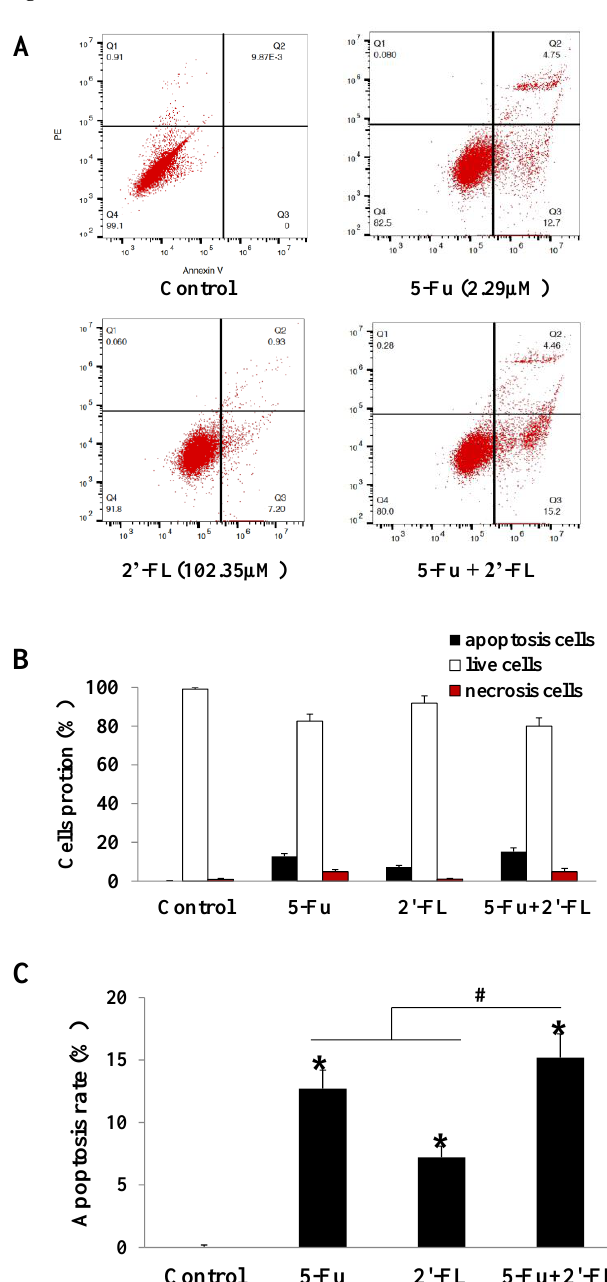
tios. The results showed that 5-Fu, 2 ’ -FL, and 5-Fu+2 ’ -FL could induce apoptosis in dif- ferent degrees of HCT116 cells. The FL combined treatment group (15.23% ± 1.94%) was compared with single 5-Fu (12.70% ± 1.51%) or single 2 ’ -FL (7.25% ± 0.98%) ( p < 0.05, Figure 2).